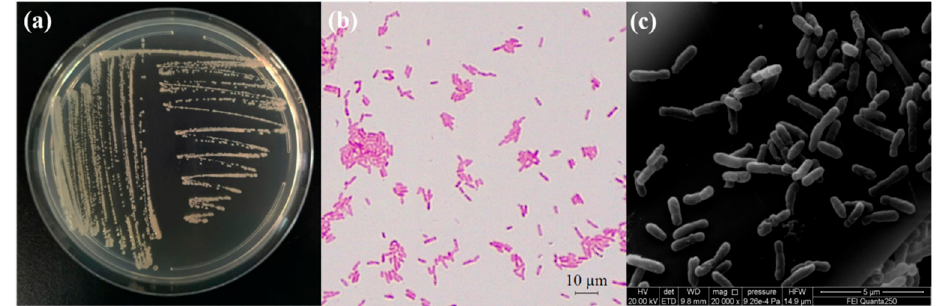
Figure 3. Observation of the morphological characteristics of the strain WM6; ( a ) strain colony morphology on the YEB medium; ( b ) Gram staining of the isolated strain; ( c ) scanning electron microscopic observation of the strain.